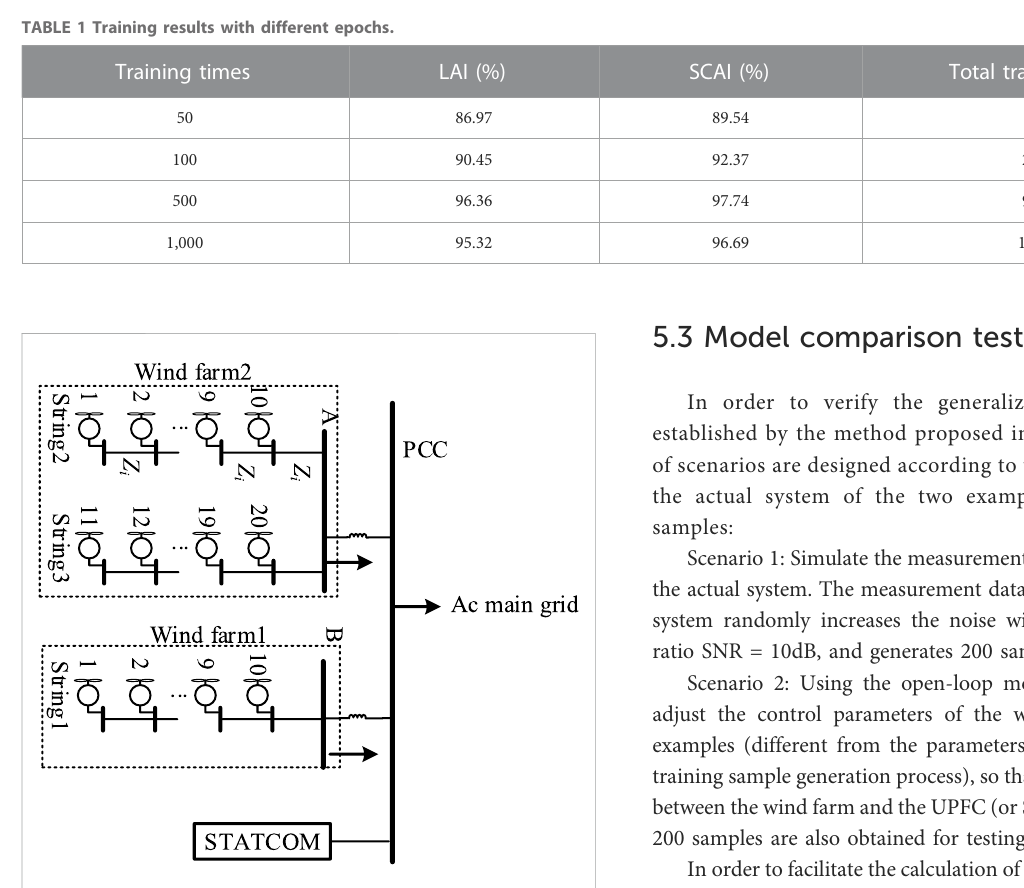
FIGURE 8 Real system structure of numerical example